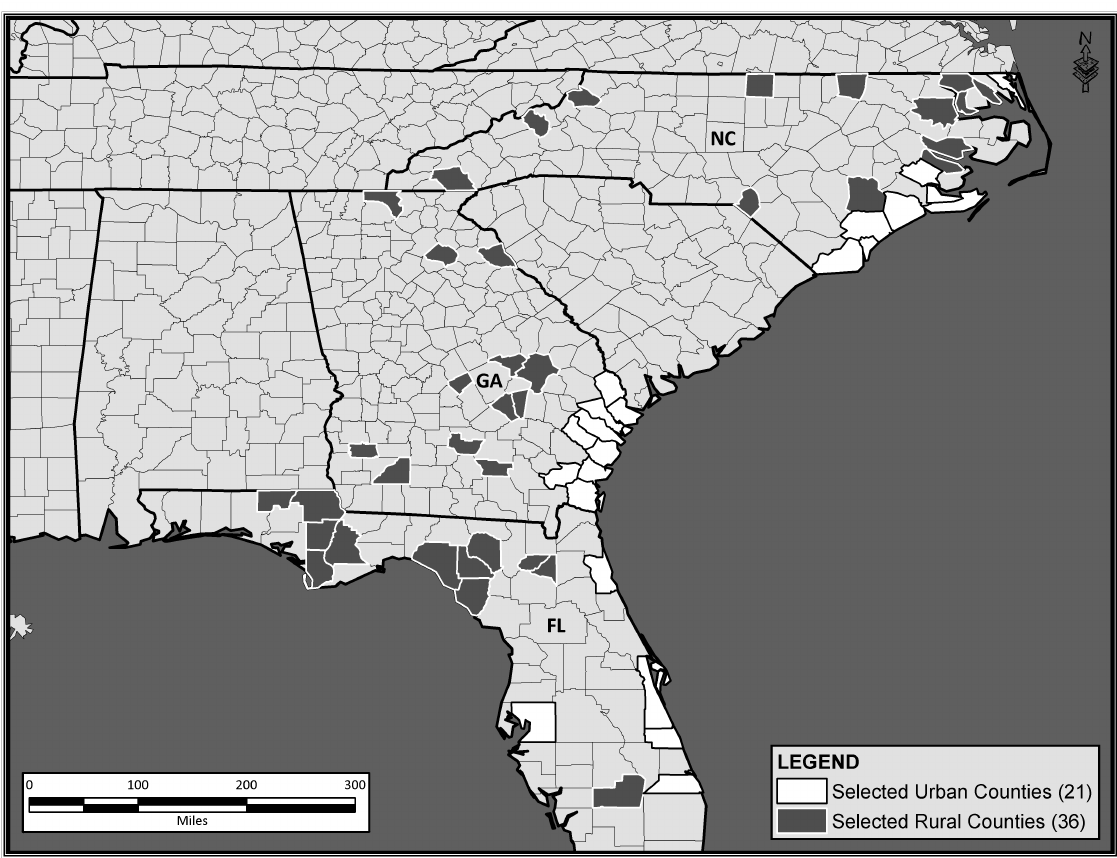
Figure 1. Location of 21 urban and 36 rural counties included in study